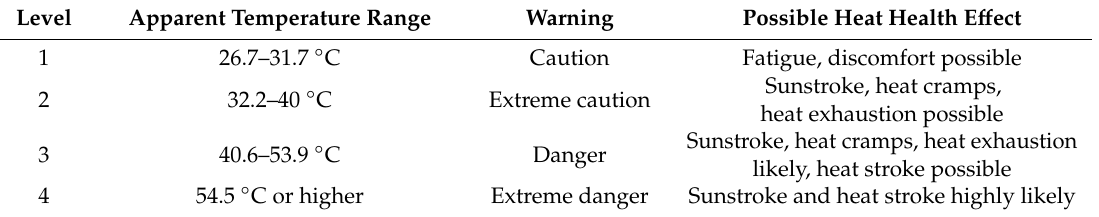
Table 1. Apparent temperature ranges and associated possible heat health e ff ects according to the USNWS NOAA Heat